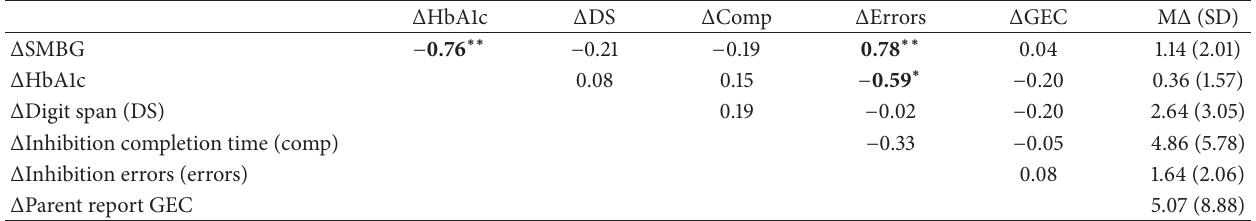
Table 2: Correlations between change scores for self-monitoring of blood glucose (SMBG), glycemic control (HbA1c), and executive